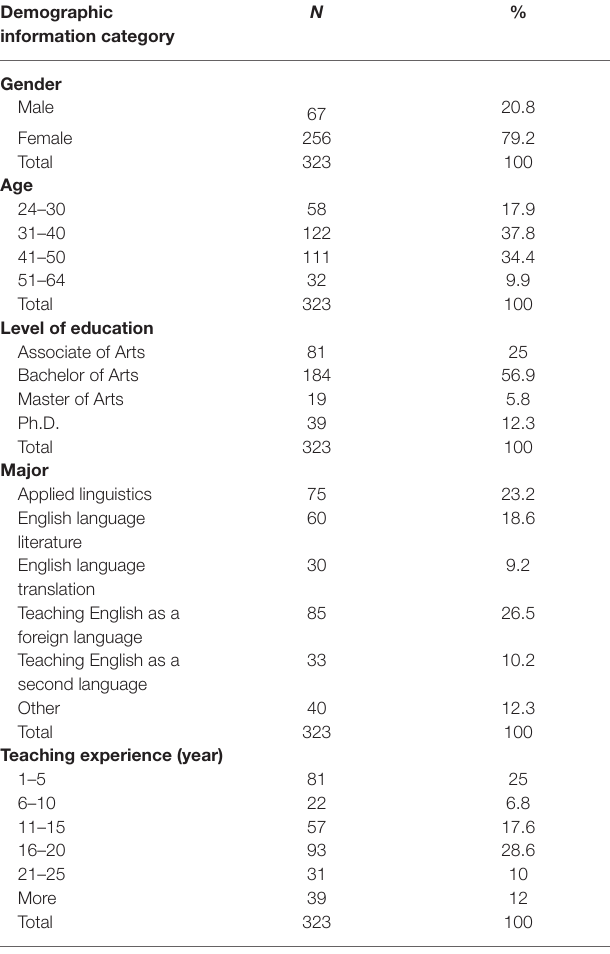
TABLE 1 | Participants’ demographic information.